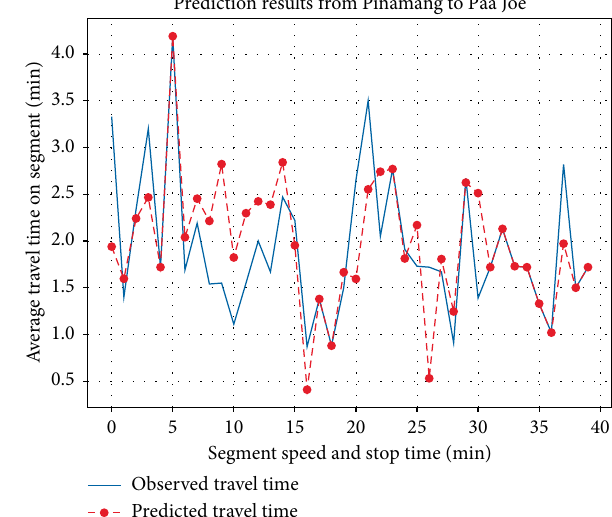
Figure 5: Choosing optimum 𝑘 -neighbour for the model. The selected neighbour was 3. Figure 6: Predicting test data using 𝑘 = 3 and 𝑁 = 21 .